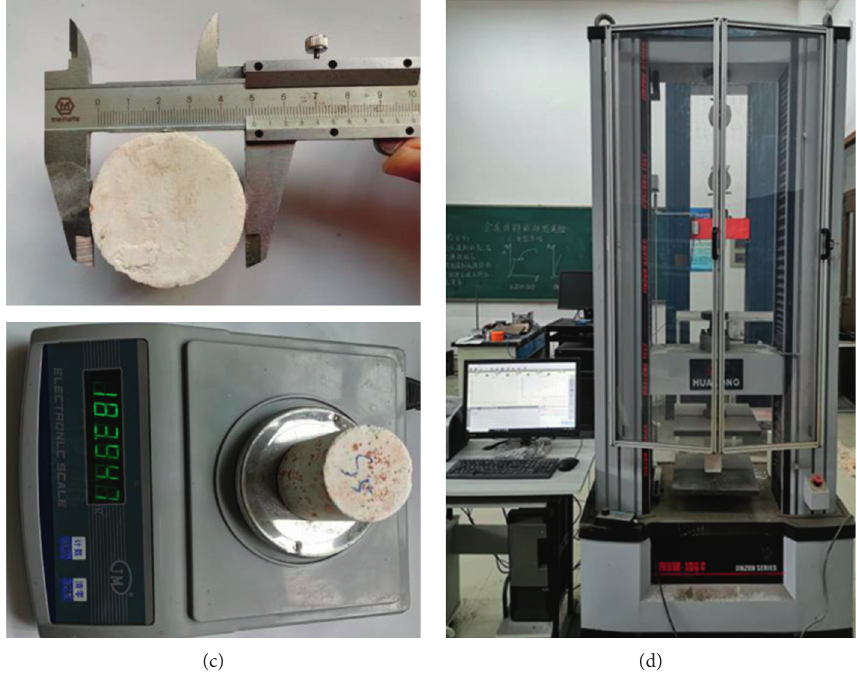
Figure 4: Testing equipment: (a) YAW-300 press machine; (b) ZT801 ultrasonic wave velocity tester; (c) vernier caliper and electronic balance; (d) universal pressure testing